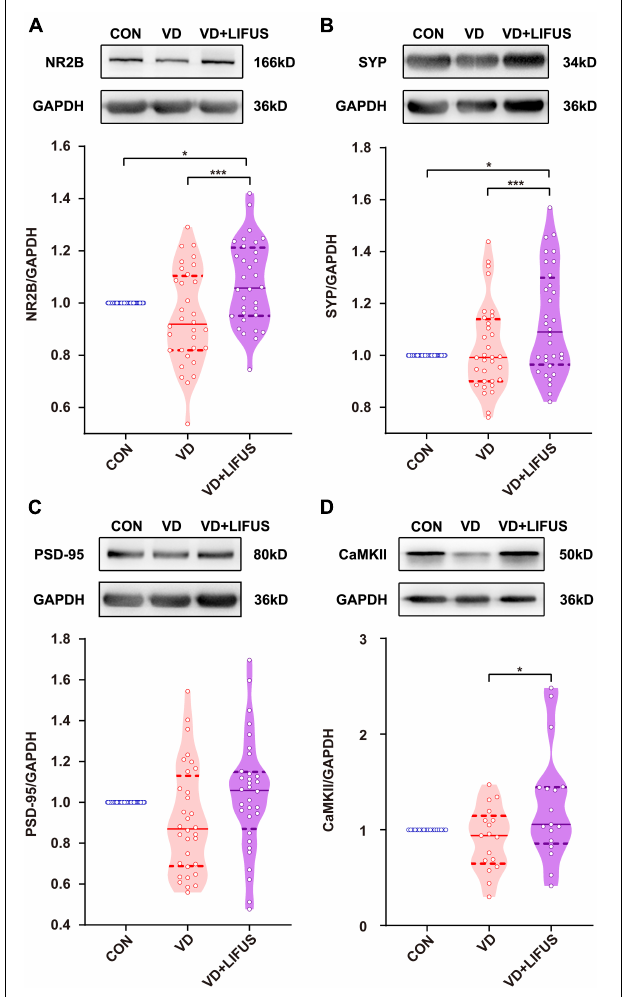
FIGURE 6 | Effect of LIFUS on the expression of synaptic proteins. (A–D) The expression of NR2B, SYP, PSD-95, and CaMKII. Data are expressed as mean ± SEM. * p < 0.05, *** p < 0.001 (CON, n = 6; VD, n = 4; VD + LIFUS, n =